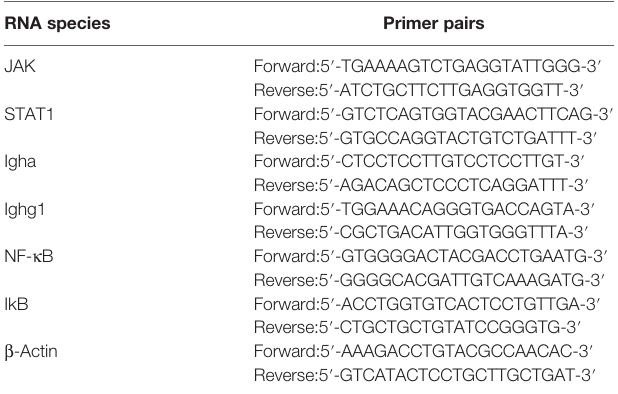
TABLE 1 | Sequences of forward and reverse primers used in